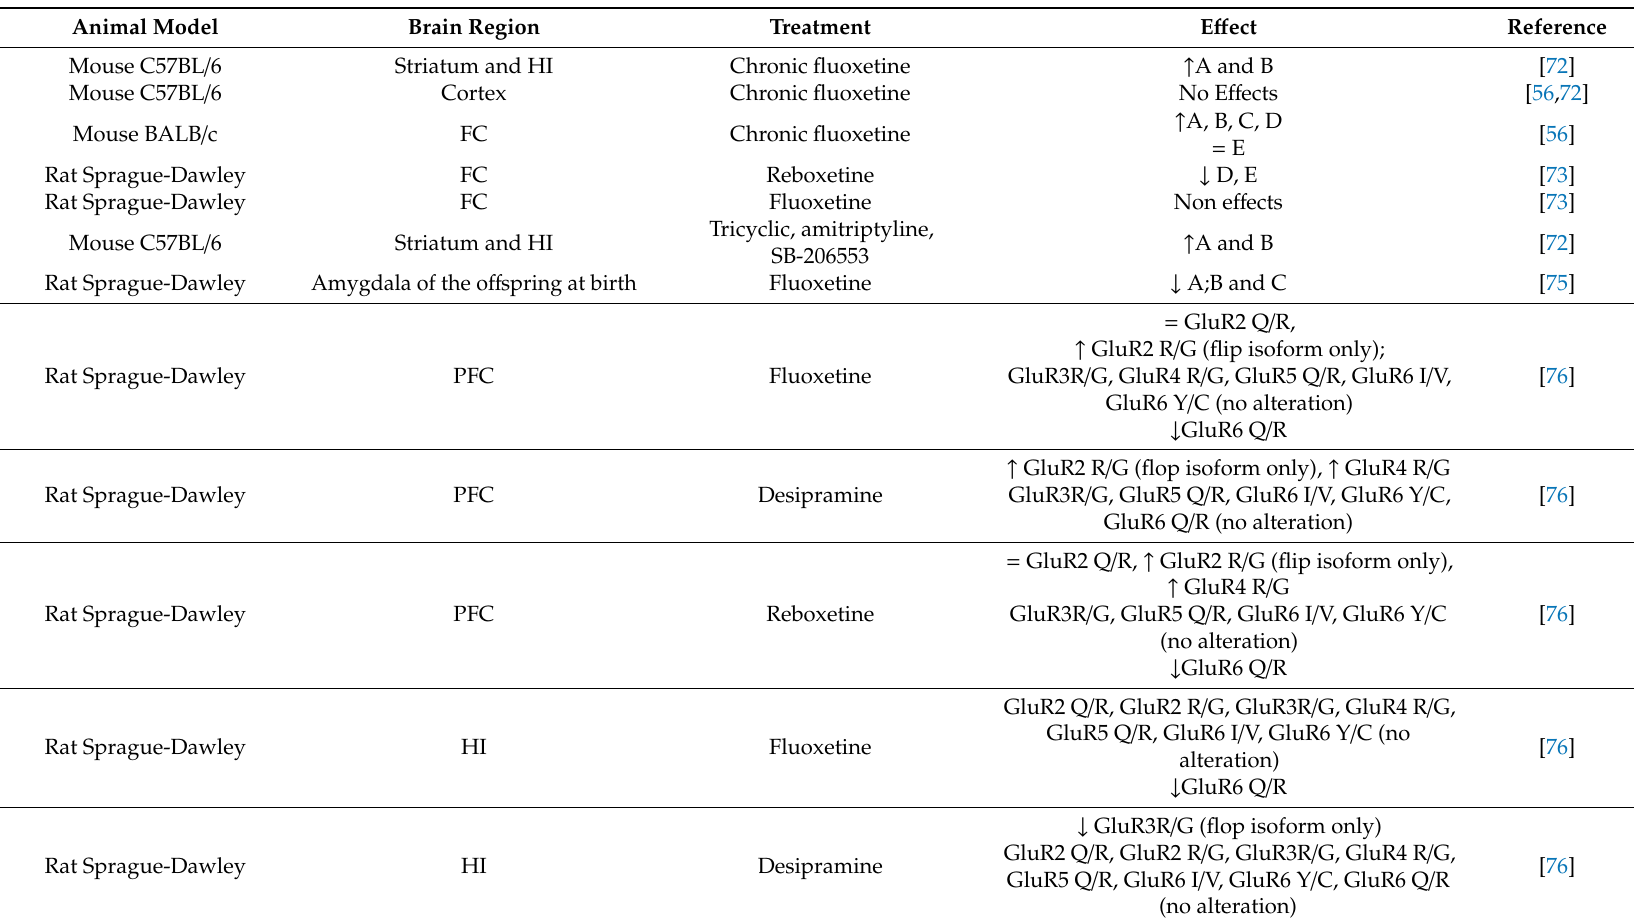
Table 2. RNA editing variations after antidepressant treatments in serotonin receptor 2C and glutamate